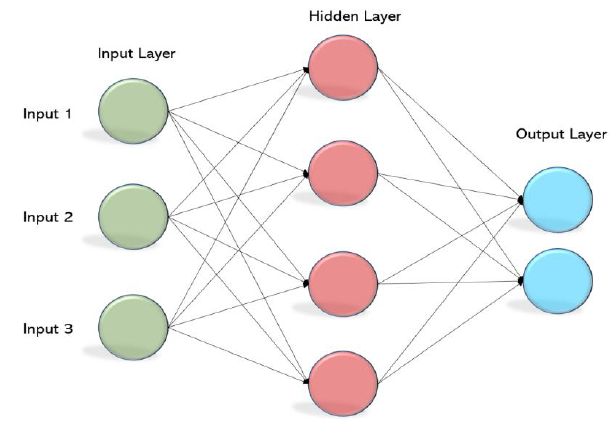
Figure 4. MLP structure [37].